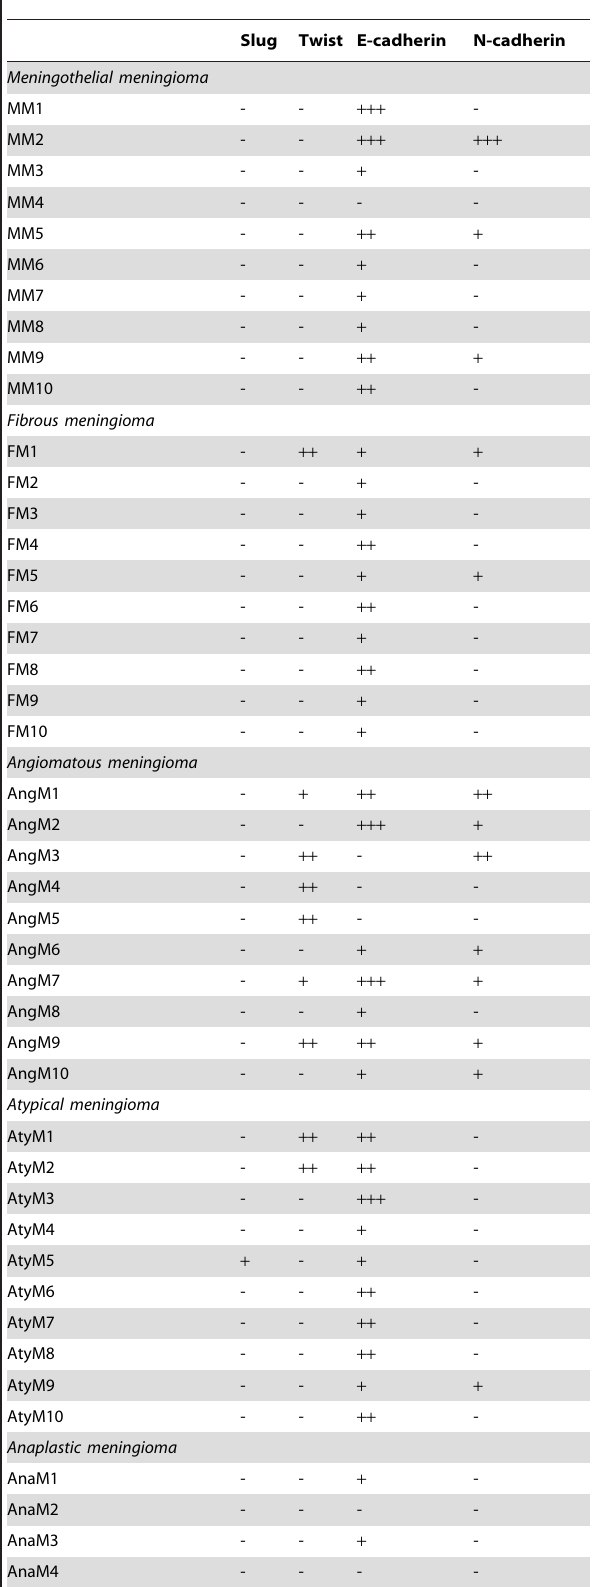
Table 1. Fraction of immunoreactive cells to Slug, Twist, E- cadherin, and N-cadherin in meningeal